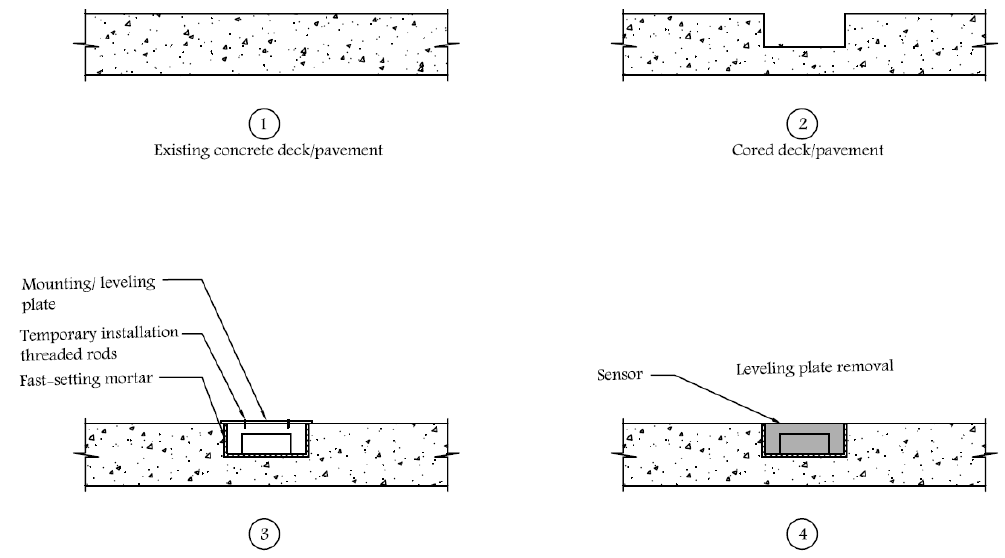
Figure 5. Installation of sensor on existing concrete deck/pavement.